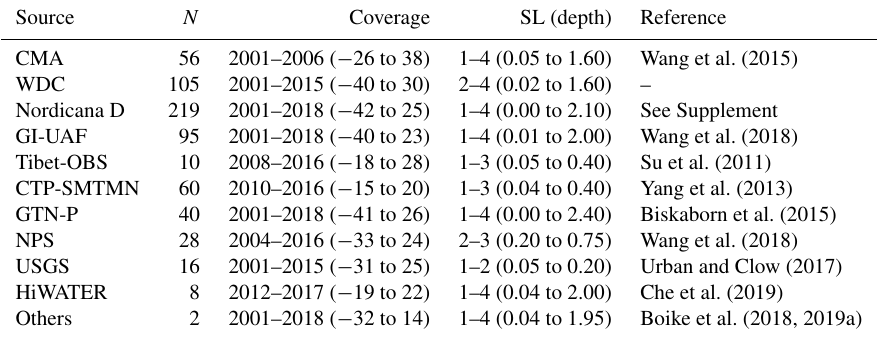
Table 1. Summary of soil temperature observations in permafrost regions, including the total number of stations ( N ), the temporal coverage and range of temperatures (Coverage), the corresponding ERA5L soil layers and depth range in meters (SL), and a reference for each dataset when available.